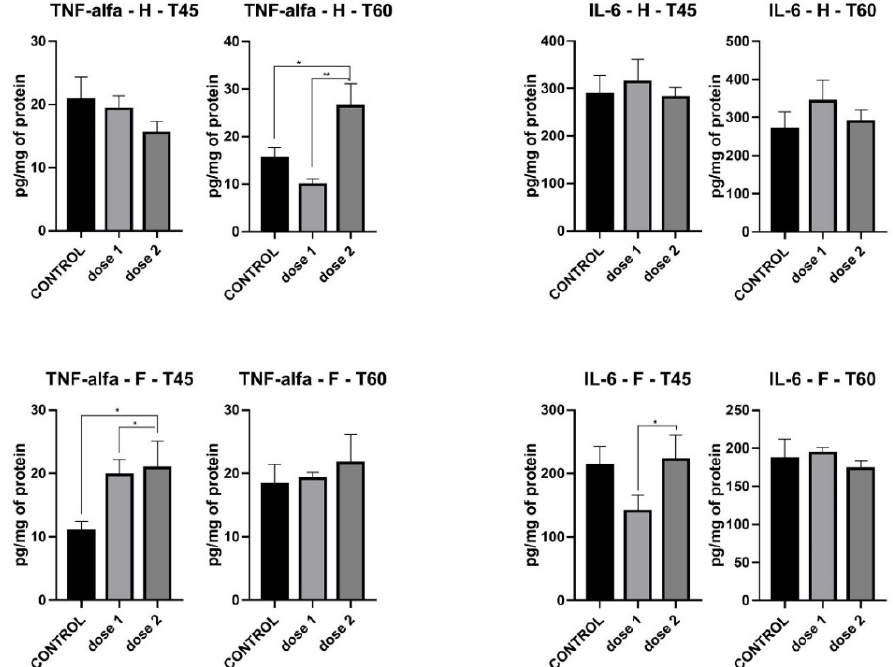
Figure 8. IL-6 and TNF-alpha levels in hippocampus (H) and frontal cortex (F) of groups sacrificed immediately after treatment (T45) and those sacrificed 15 days post-treatment (T60). * p < 0.05; ** p < 0.01.